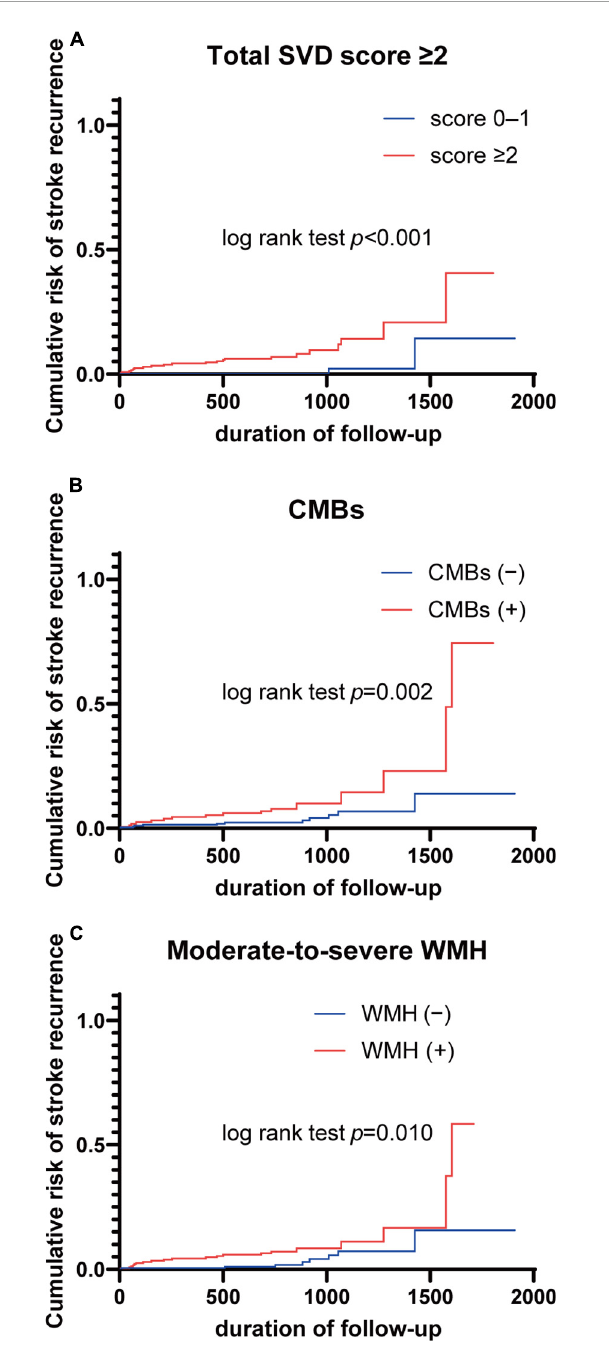
FIGURE2 Kaplan–Meier curves for stroke recurrence according to total SVD score and neuroimaging markers. (A) Total SVD score ≥ 2; (B) CMBs; (C) moderate-to-severe WMH. CMBs, cerebral microbleeds; SVD, small vessel disease; WMH, white matter hyperintensity.